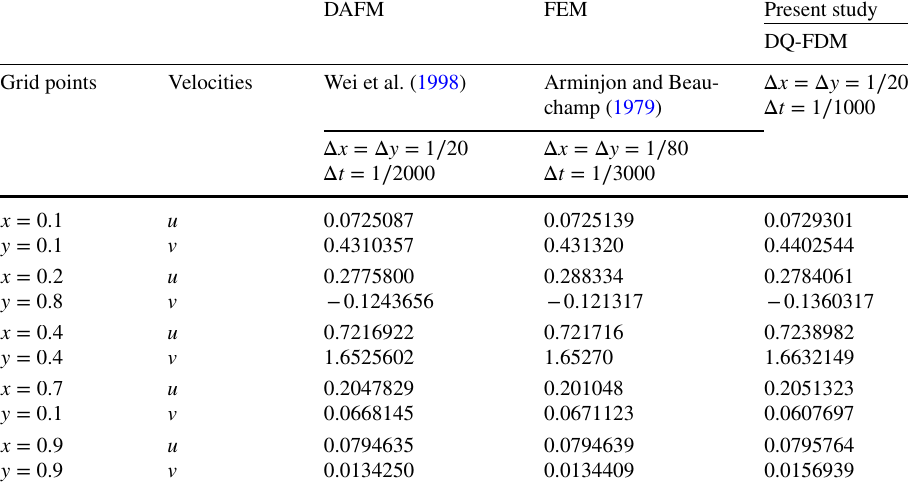
DAFM FEM Present study